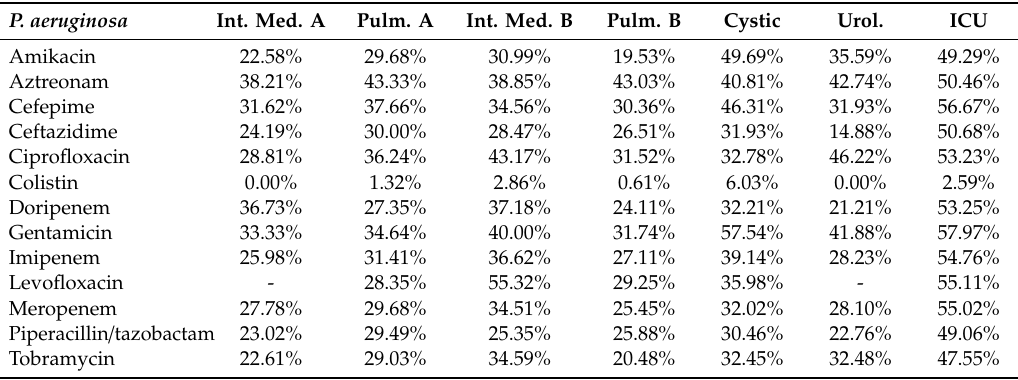
Table A2. Resistance rates for P. aeruginosa per ward per antibiotic during the 2 years (2017–2018). P.